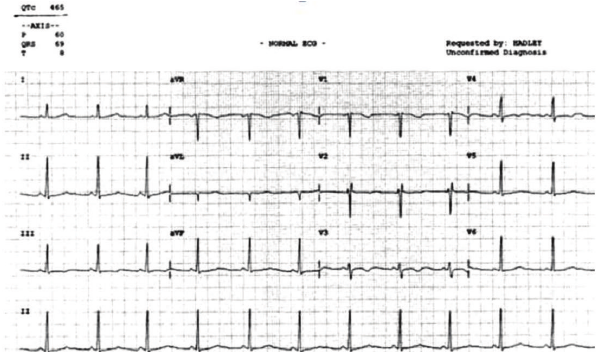
Figure 1: Initial electrocardiogram obtained in the emergency department. Note the prolonged QT interval of 521 ms.